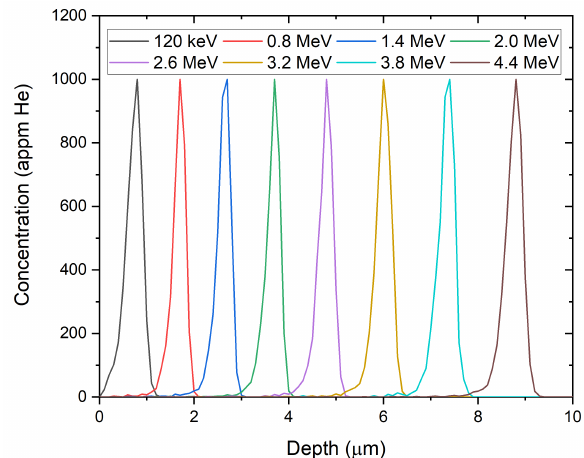
Figure 4. Helium concentration with depth into a copper target, as simulated using SRIM for each energy used here.